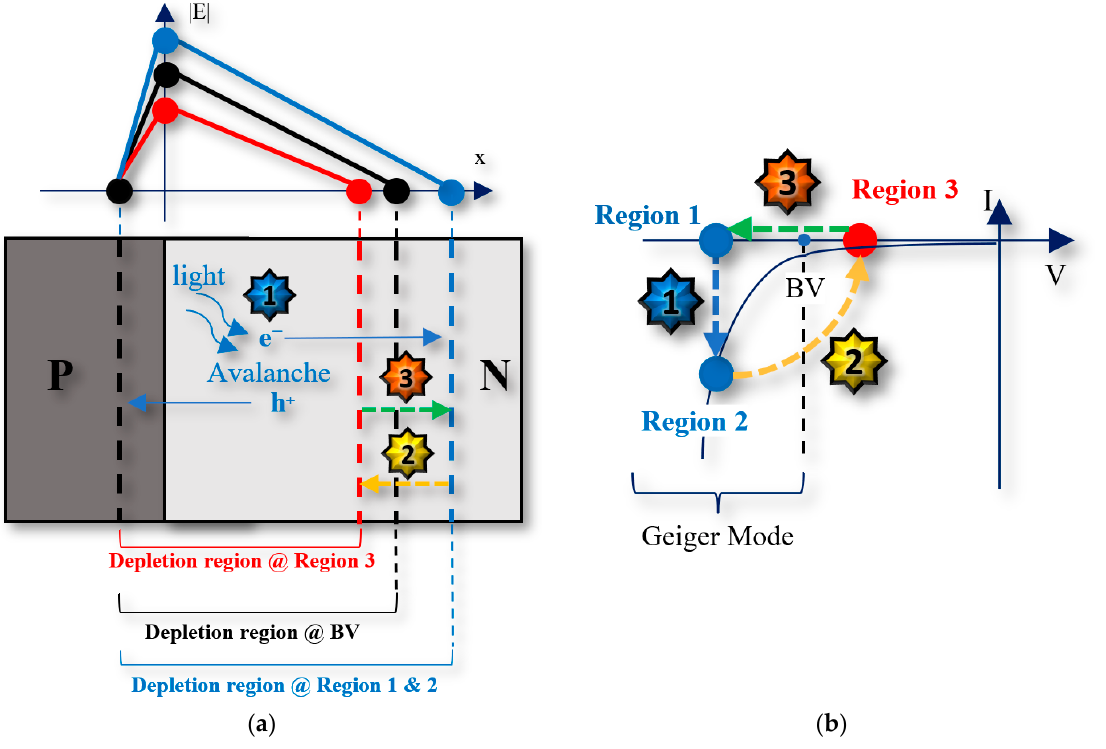
Figure 2. ( a ) Simple SPAD diagram ( b ) Current-voltage (I-V)